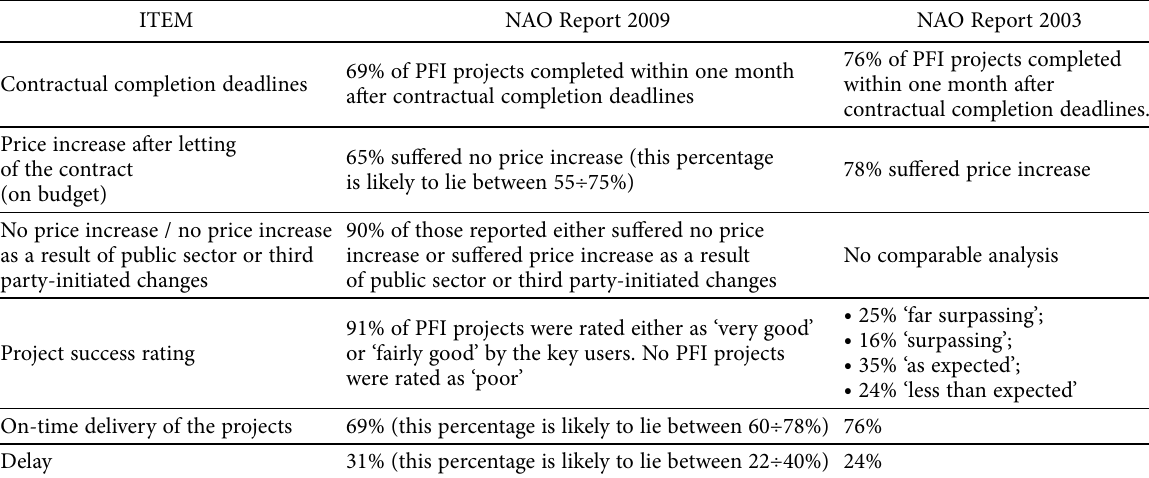
Table 4. Comparison of NAO (2009) Report with NAO (2003) Performance of PFI Construction